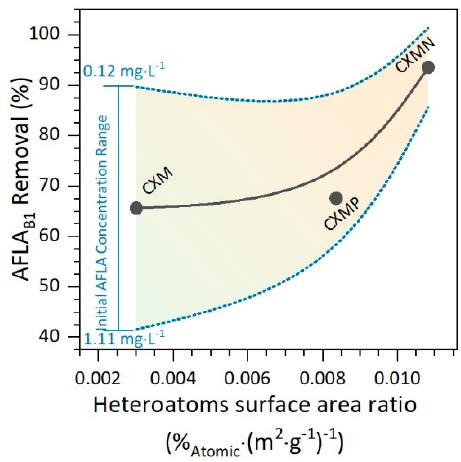
Figure 6. Aflatoxin B1 (AFLA B1 ) removal at 15 min as a function of heteroatoms per area unit (polarity), using carbon xerogel microspheres (CXMs) and CXMs functionalized with melamine (CXMN) and phosphoric acid (CXMP) at 37